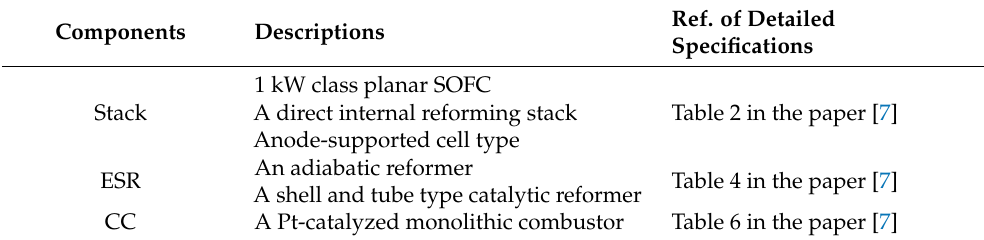
Figure 1. Schematic diagram of a solid oxide fuel cell (SOFC) system with anode off-gas recirculation (AOGR) (AOGR #2 system in ref. [7]). Table 3. Descriptions of the main